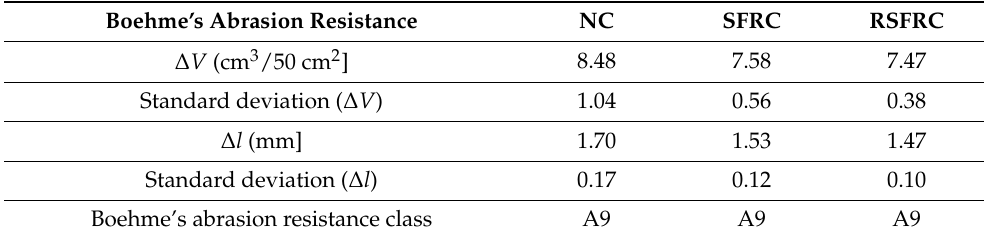
Table 7. Results of Boehme’s abrasion resistance tests.